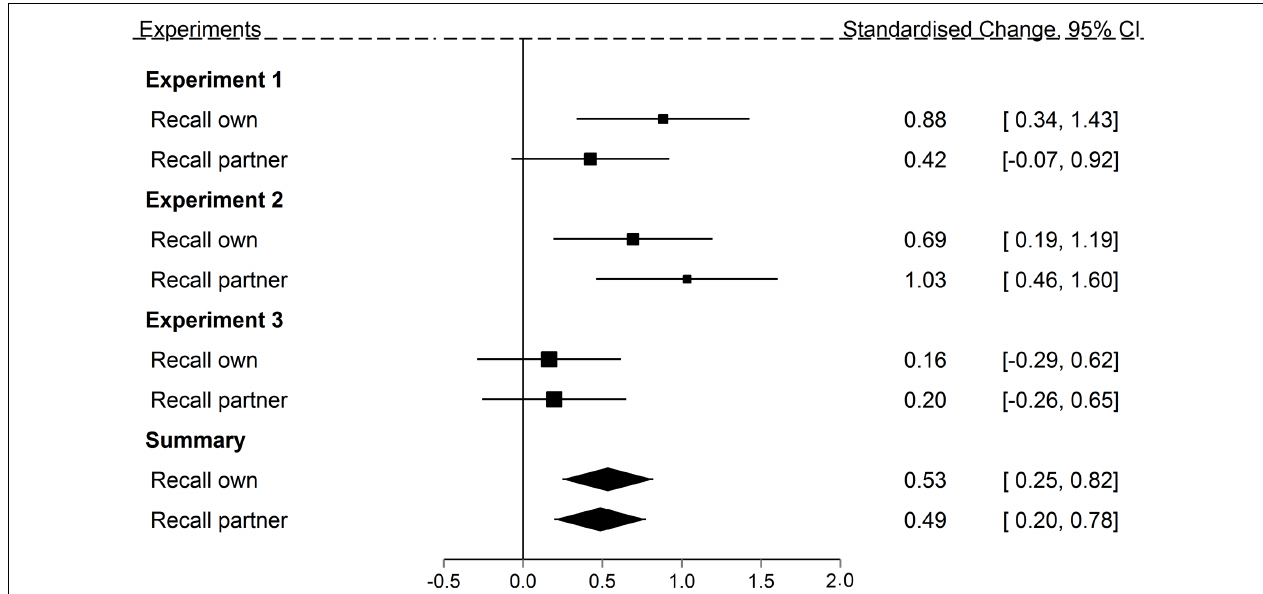
FIGURE 7 | Standardized mean change between observed and predicted source errors committed in Experiments 1 through 3 in both the Recall own and Recall partner task when action were encoded without a concurrent load. Size of the squares represents the weights of the individual comparisons. The error bars are 95% confidence interval. The polygons represent the summary effects (fixed effects) of the Recall own and the Recall partner task, respectively, across all three experiments.